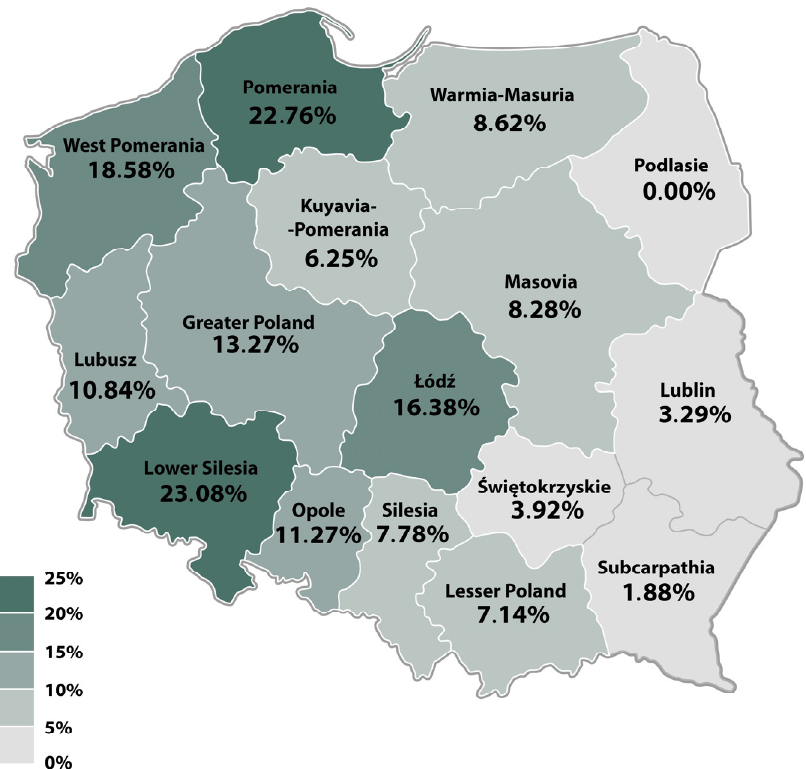
Figure 1. Percentage share of municipalities adopting spatial plans for wind power plants in the total number of municipalities for each province in Poland. Source: own elaboration.